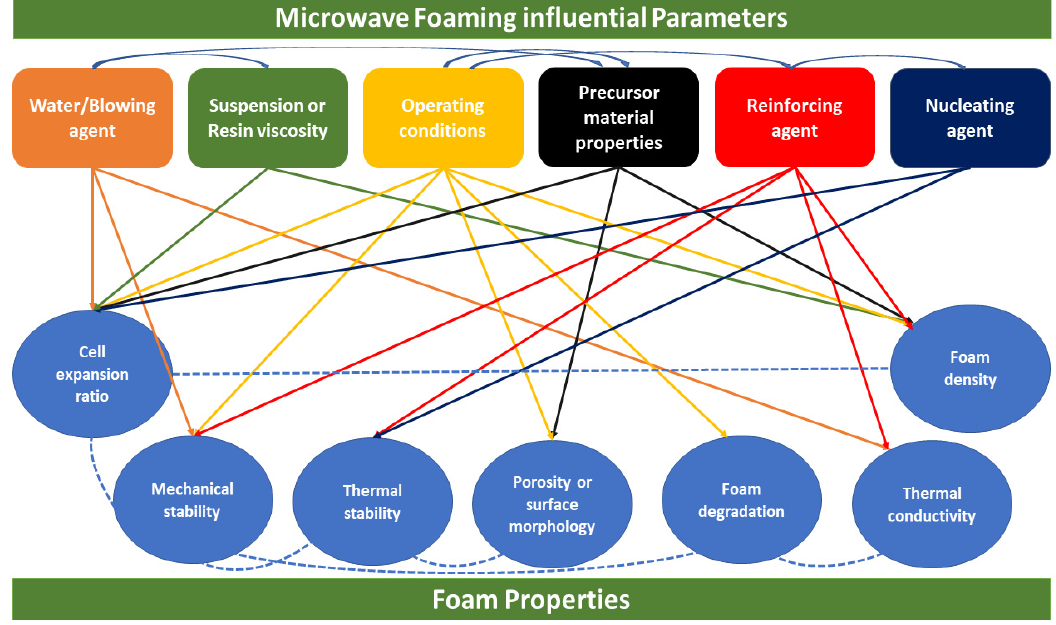
Figure 7. Microwave foaming influential parameters are affecting foam product properties.